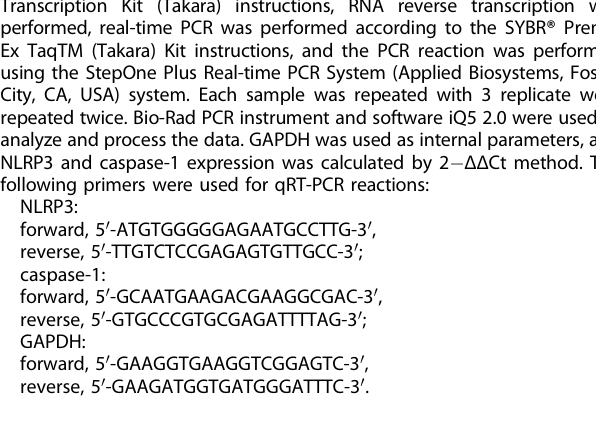
according to the manufacturer ’ s instructions.